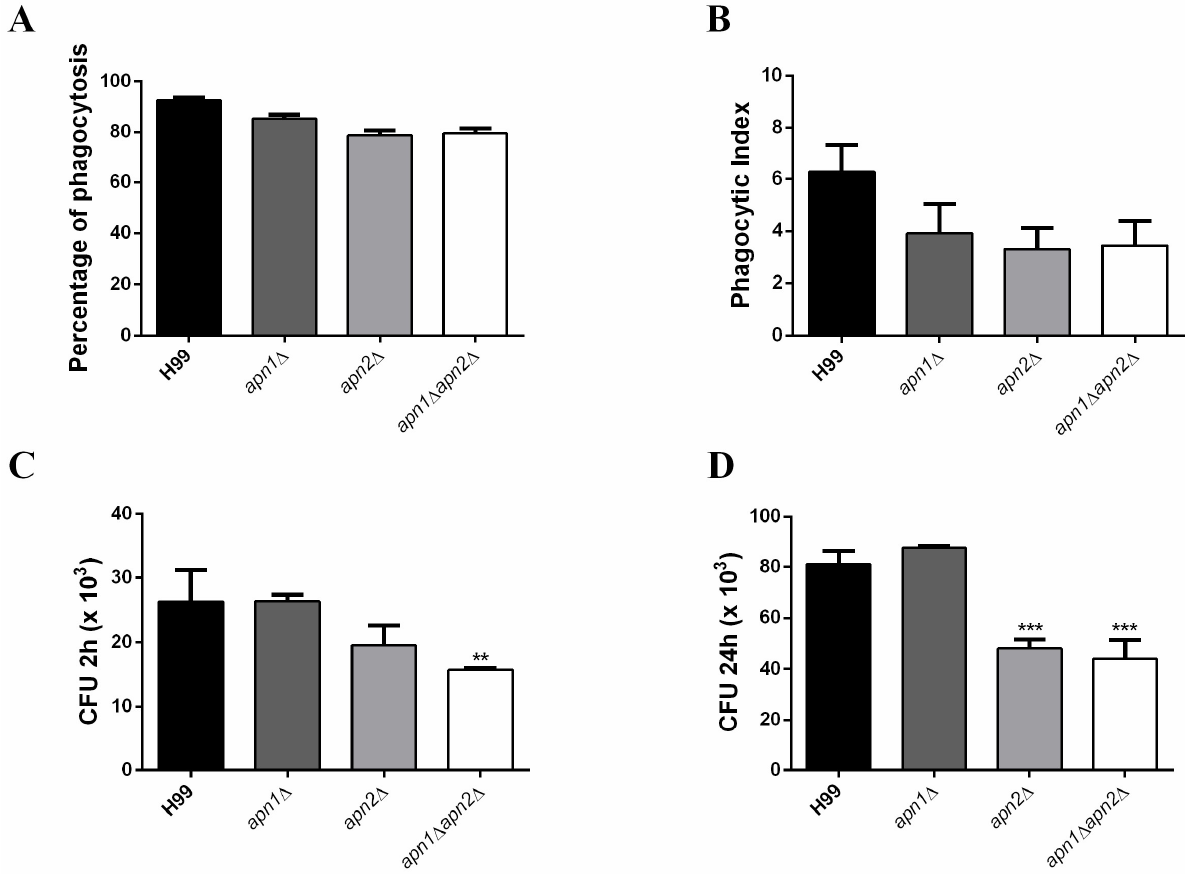
Figure 8. The deletion of APN-like genes results in C. neoformans reduced phagocytosis and survival in macrophages in vitro. Bone marrow-derived macrophages (BMDMs) were co-cultured for 2 h or 24 h with previously opsonized fungal cells from the different strains of C. neoformans . Each strain was inoculated into three wells of a 96-well polystyrene plate containing macrophages at a MOI of 5. ( A ) Percentage of phagocytosis. Data are presented as mean ± 95% C.I. ( n = 3 experiments, *** p < 0.001). ( B ) Phagocytic index. ( C ) CFU counts of C. neoformans strains recovered from bone marrow-derived macrophages (BMDMs) after 2 ( D ) or 24 h of co-incubation. Error bars represent standard errors of the mean of three biological replicate experiments. The wild-type H99 was used as a control group for statistical comparison. Statistical test: One-way ANOVA with Dunnett’s post-test, ** p < 0.01.